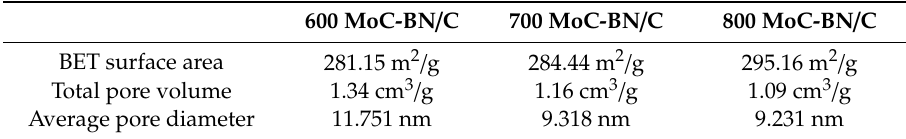
Table 1. Surface properties of MoC-BN/C at different heat-treatment temperatures.